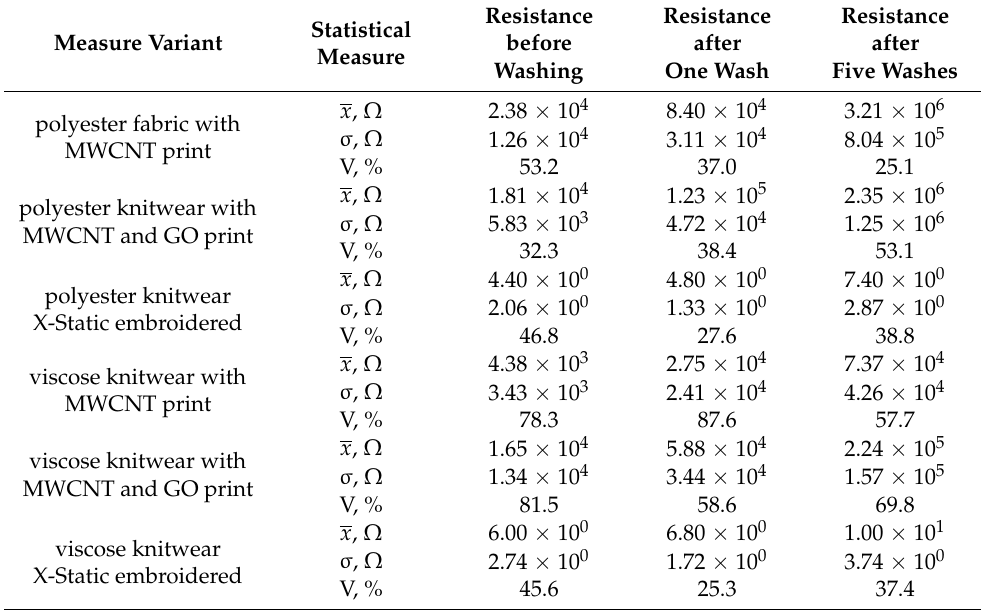
Table 7. Cont. Measure Variant